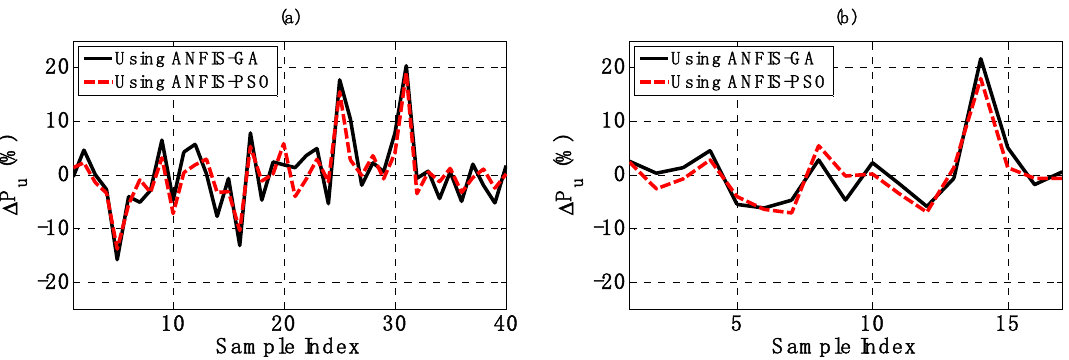
σ u are the average and standard